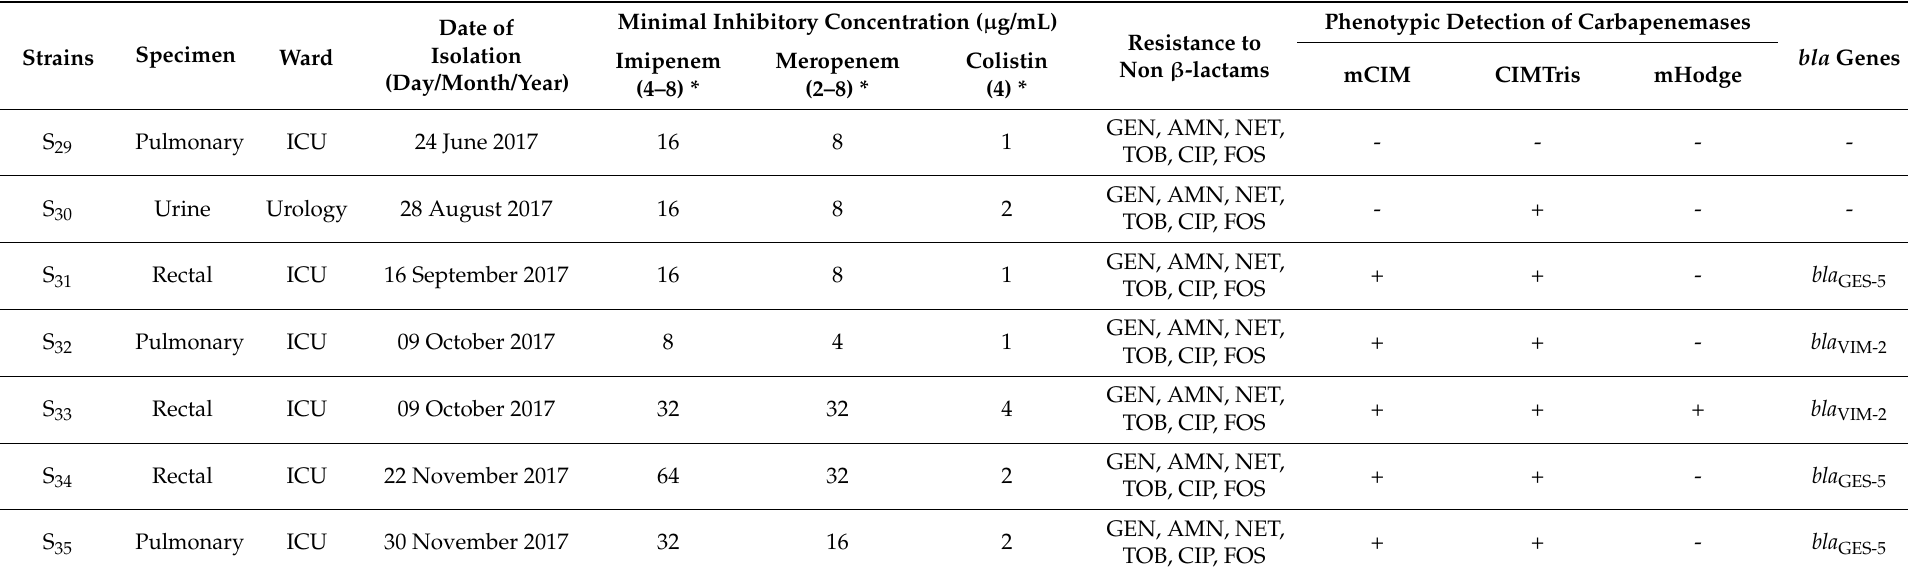
Table 4. Characteristics of imipenem- and ceftazidime-resistant P. aeruginosa isolates ( n =